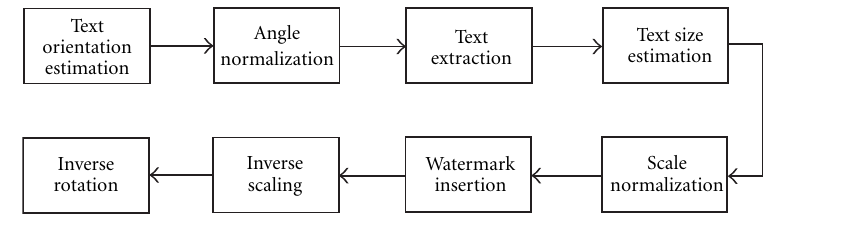
Figure 4: Overall scheme of TBGN-based watermark encoding.